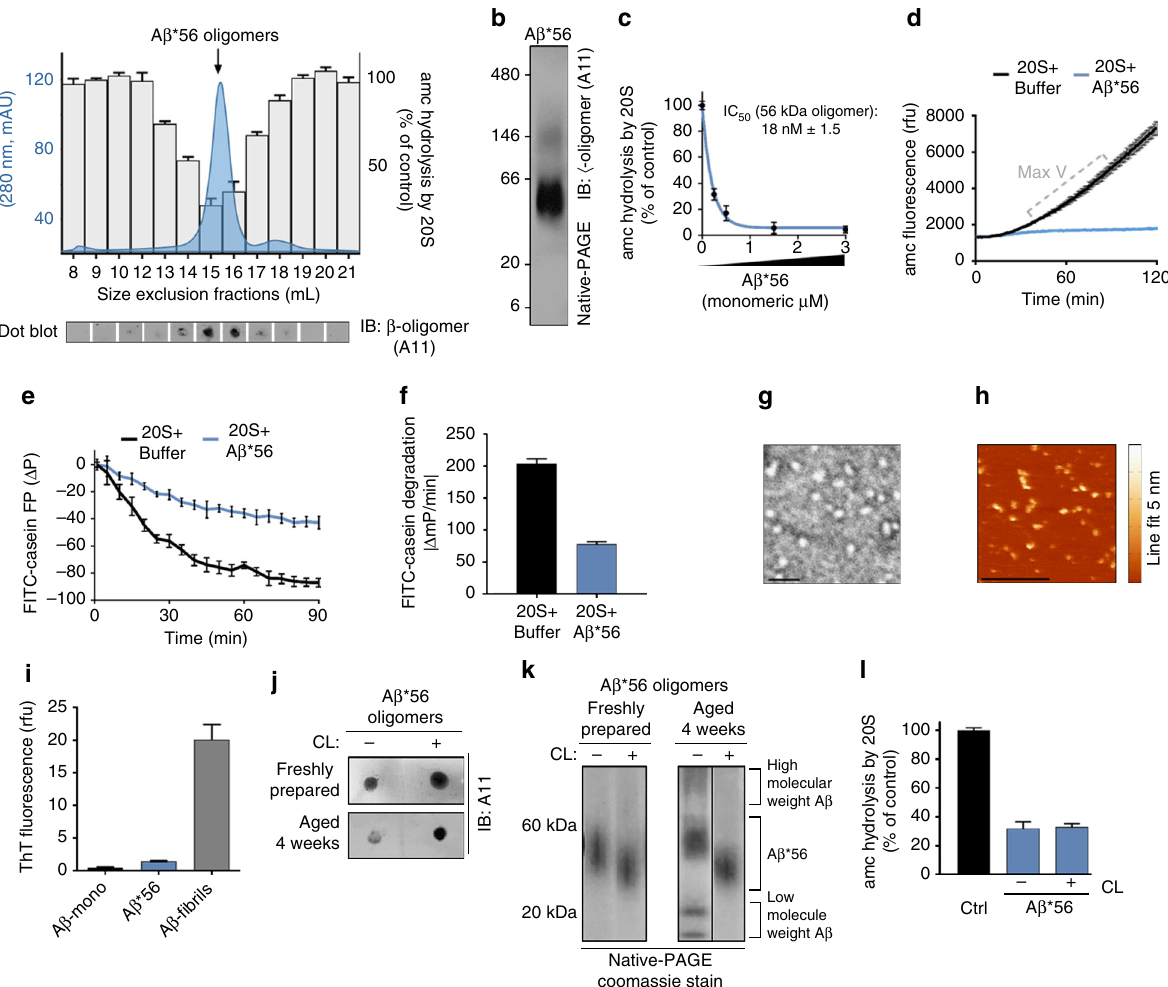
Fig. 2 Generation of stabilized A11 + oligomers (Ab*56) for mechanistic evaluation of proteasome inhibition. a Size exclusion chromatography (Superose 6 GL 10/300) run that was used to generate a pure A β *56 oligomer preparation (blue solid line, left axis), with proteasome activity (amc hydrolysis) from 1 μ l of the corresponding fractions (bars, right axis; as in Fig. 1), and A11 dot blot (bottom panel). b Native-PAGE A β *56 peak fraction from a followed by western blot using the A11 anti-oligomer antibody. c Proteasome activity (LLVY-amc hydrolysis) with titrating A β *56; the IC 50 is ~0.22 μ M A β (4.5 kDa monomeric mass) or 18 nM A β *56 oligomer complexes (56 kDa mass each). d Representative raw data of proteasome activity assay (nLPnLD-amc hydrolysis) with 1.5 μ M A β *56 oligomers (data point from c ). e Change in polarization of FITC-labeled-casein protein (due to cleavage) in the presence of the 20S proteasome, with and without 10 μ M A β *56. f Rate of FITC-casein degradation ( Δ mP/min). g Representative negative stain electron microscopy image of puri fi ed A β *56 oligomers. Scale bar is 25 nm. h Representative tapping mode atomic force microscopy topography image of A β *56 oligomers. Scale bar is 0.5 μ m. Heat map for oligomer height is shown on the right. i ThT fl uorescence of the indicated Ab preparations. j , k Dot blot with A11 antibody i and oligomer native gel electrophoresis visualized by Coomassie stain k of non-crosslinked and glutaraldehyde crosslinked (CL) A β *56 oligomers before and after 4-week incubation at 4 °C. l Proteasome activity (nLPnLD-amc hydrolysis) in the presence of CL and non-crosslinked A β *56 oligomers (0.75 μ M). Concentration of A β *56 oligomers is calculated based on the mass of peptide monomer (A β , 4.5 kDa). All controls contained an equal volume of buffer identical to that of the respective aggregates. Proteasome activity was calculated as in Fig. 1a. The data are representative of three or more indicated